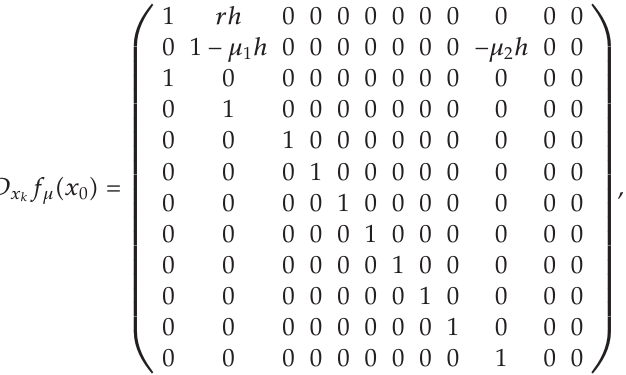
the bifurcation parameter point P 2 such that the change of the parameter μ 1 is not sensitive for the complex conjugate eigenvalues lying on the unit circle at P 2 to cross the unit circle. Therefore, the ideal bifurcation parameter point anticontrol of this bifurcation is accurately located at the point P 1 (cid:4) − 0 . 725229 , 1 . 248199 (cid:5)